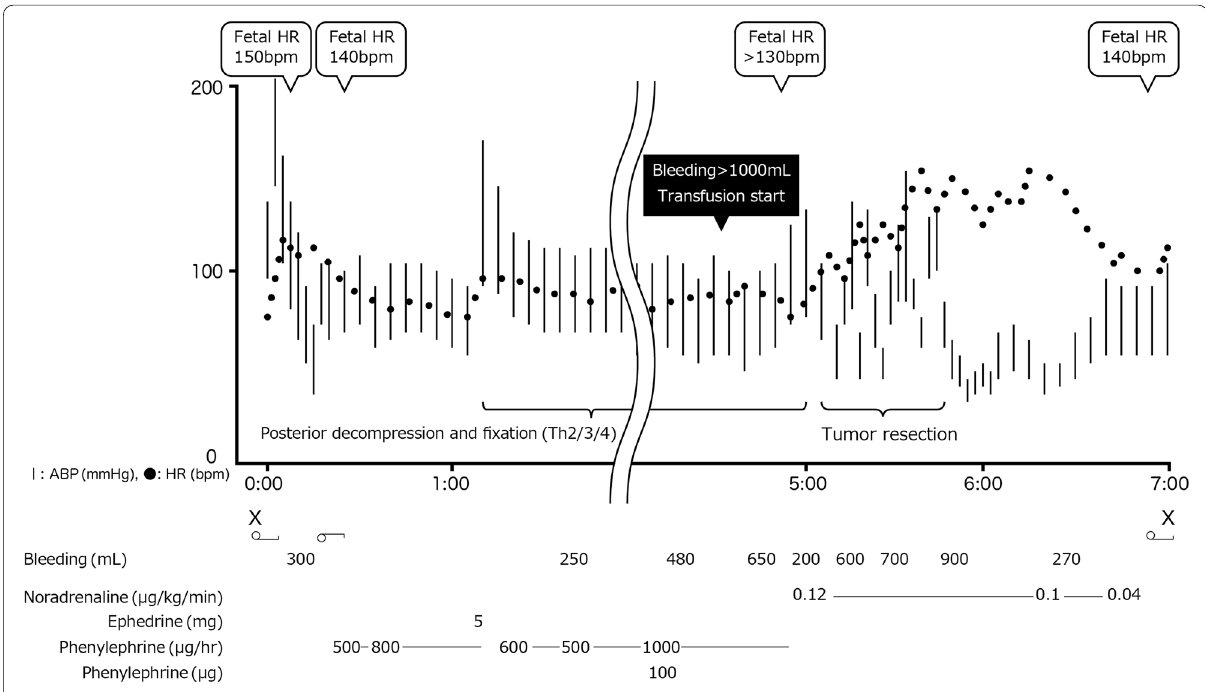
Fig. 2 Anesthesia record. HR, heart rate; ABP, arterial blood pressure; X, anesthesia